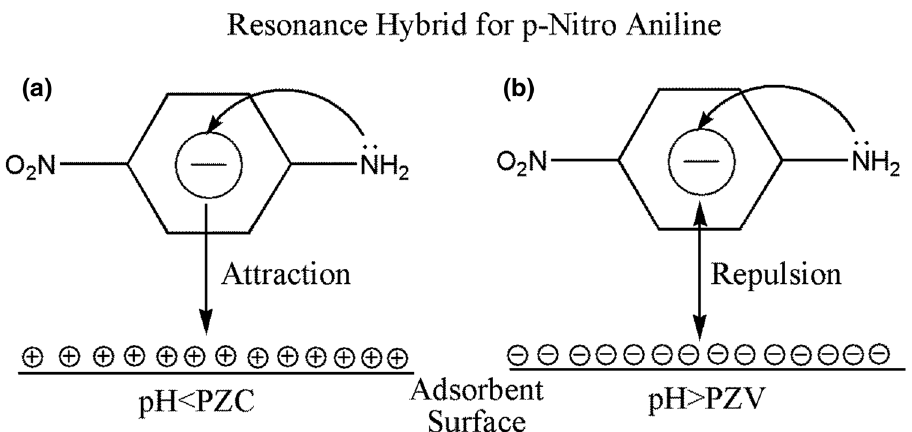
Fig. 10 Scheme of adsorp- tion involving PNAN and the sorbents in a electro-attractive,